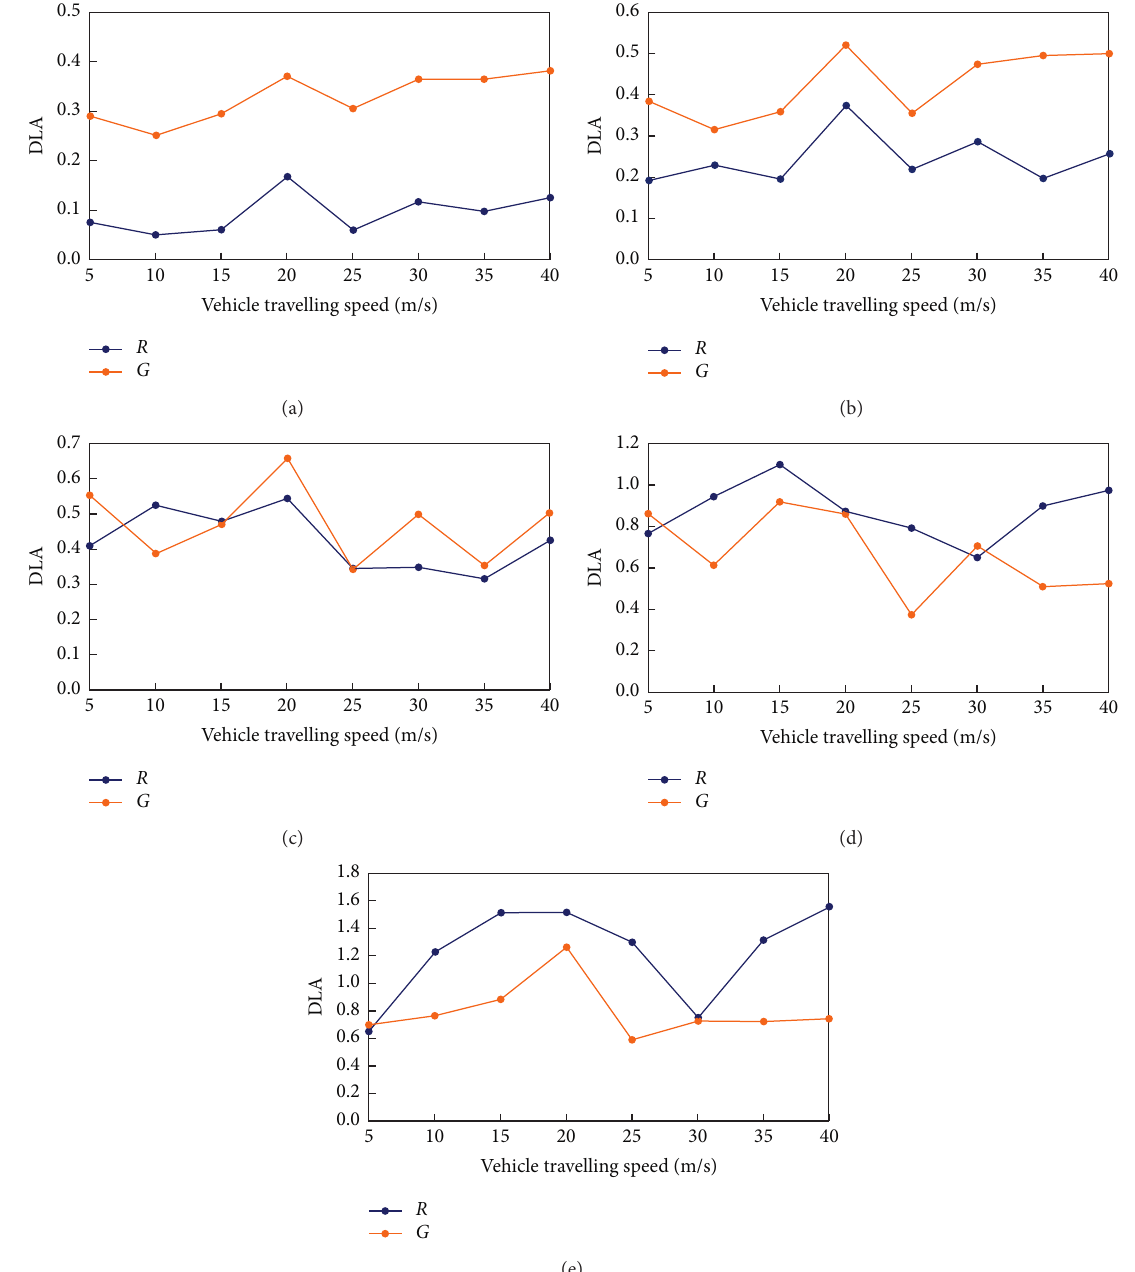
Figure 10: DLAs for the displacement of different components with various pavement roughnesses: (a) very good; (b) good; (c) average; (d) poor; (e) very